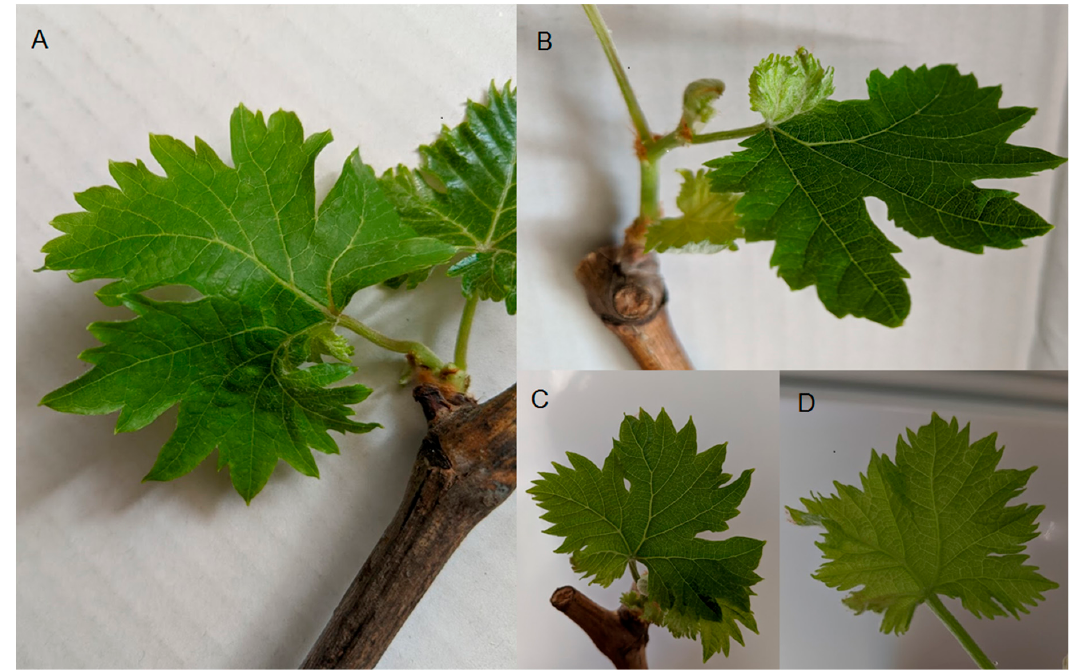
Figure 1. Symptoms frequently observed in GPGV-positive cv. Sabel sampled in the Boumerdes region. ( A ) Deformation of the leaf basis (AL_41); ( B ) greening of the leaf basis (AL_41); ( C , D ) leaf deformation (AL_42).